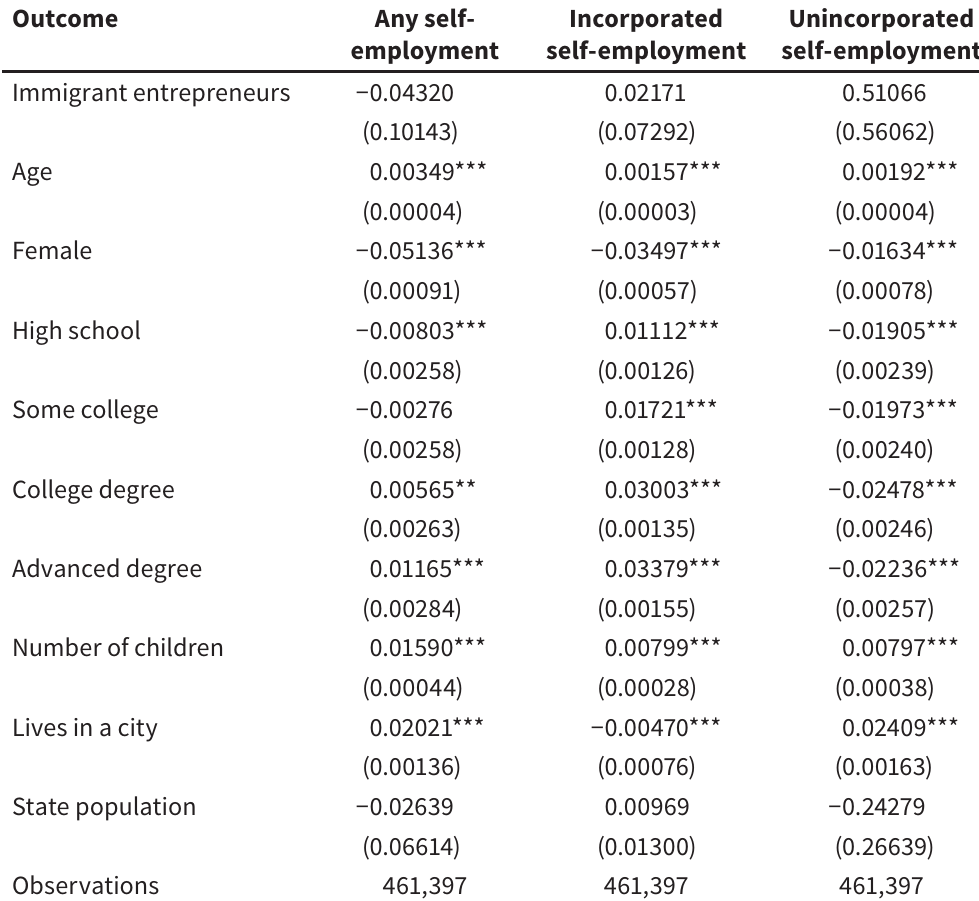
Heterogeneity in the Impact of Immigrant Entrepreneurs across Races of Natives: Second Stage Estimates for